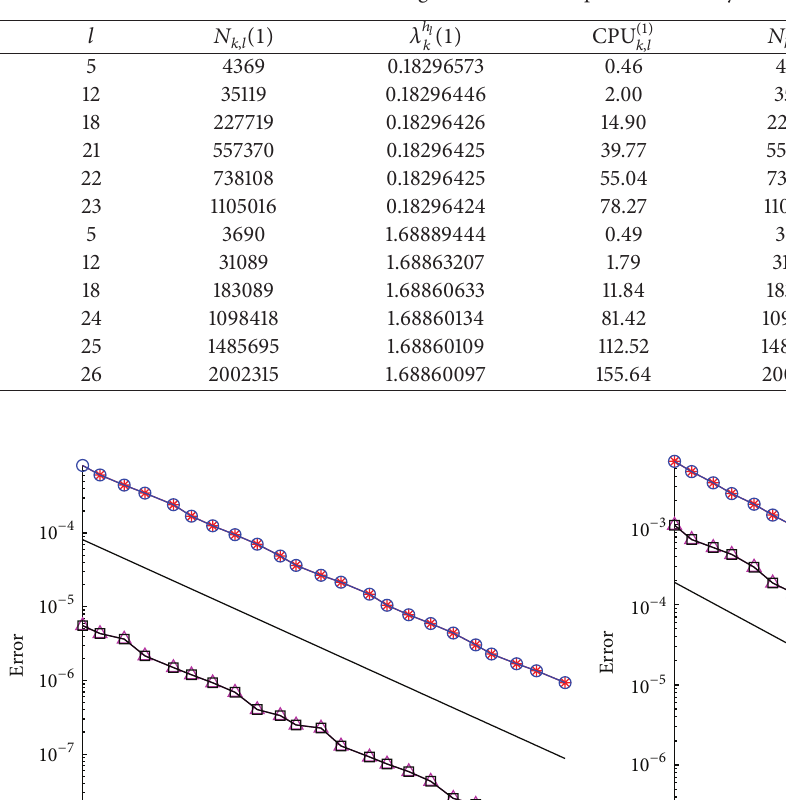
Table 2: The 1st and the 3rd eigenvalues of Example 2 obtained by two algorithms with 𝐻 = √2/32 .